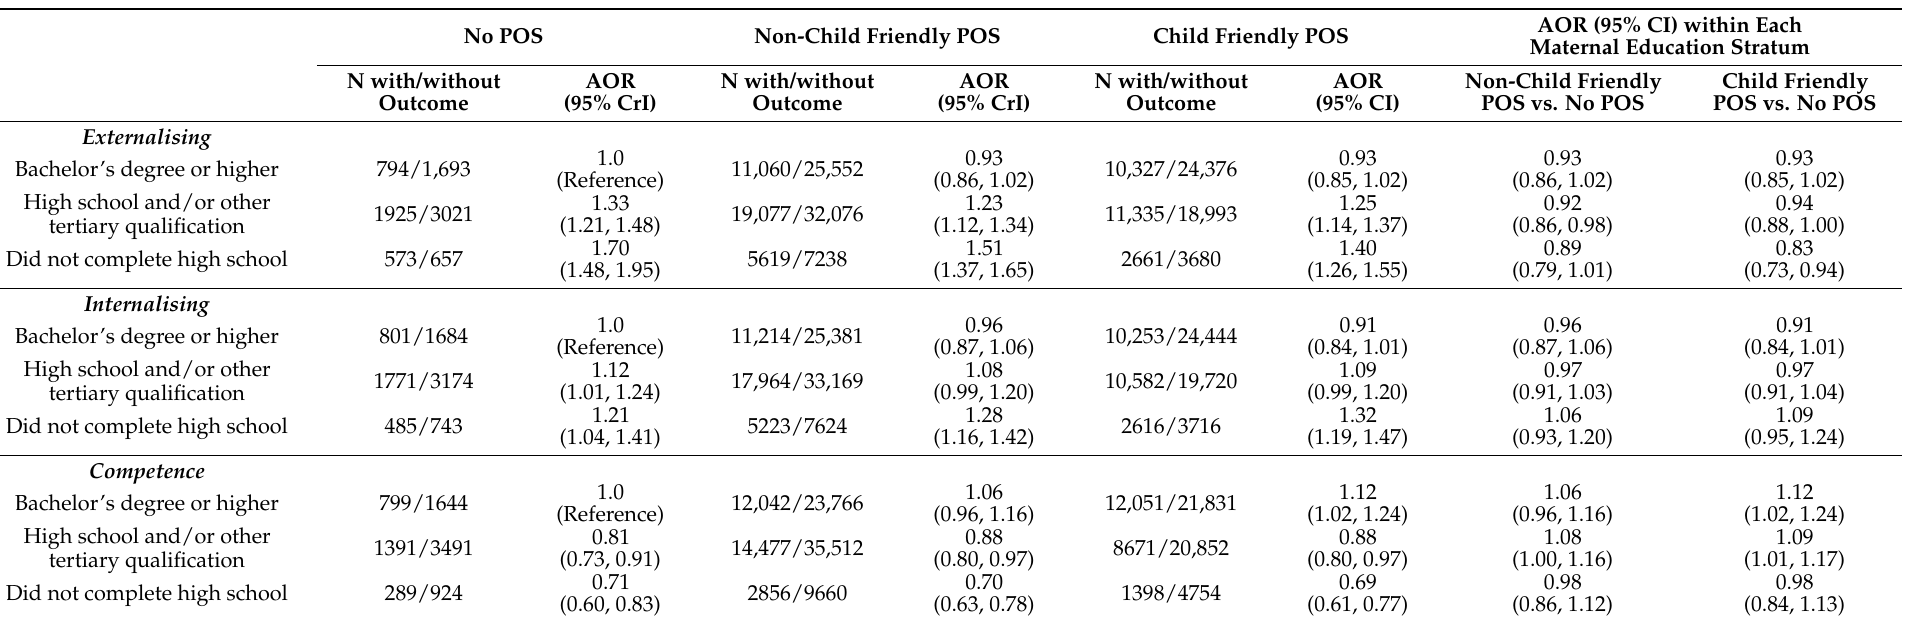
Table 3. Results from the investigation of effect modification for measures of public open space within 800 m. Based on template developed by Knol and VanderWeele [67]. AOR (95% CI) within Each No POS Non-Child Friendly POS Child Friendly POS Maternal Education Stratum AOR AOR AOR N with/without N with/without N with/without Non-Child Friendly Child Friendly (95% CrI) (95% CrI) (95% CI) Outcome Outcome Outcome POS vs. No POS POS vs. No